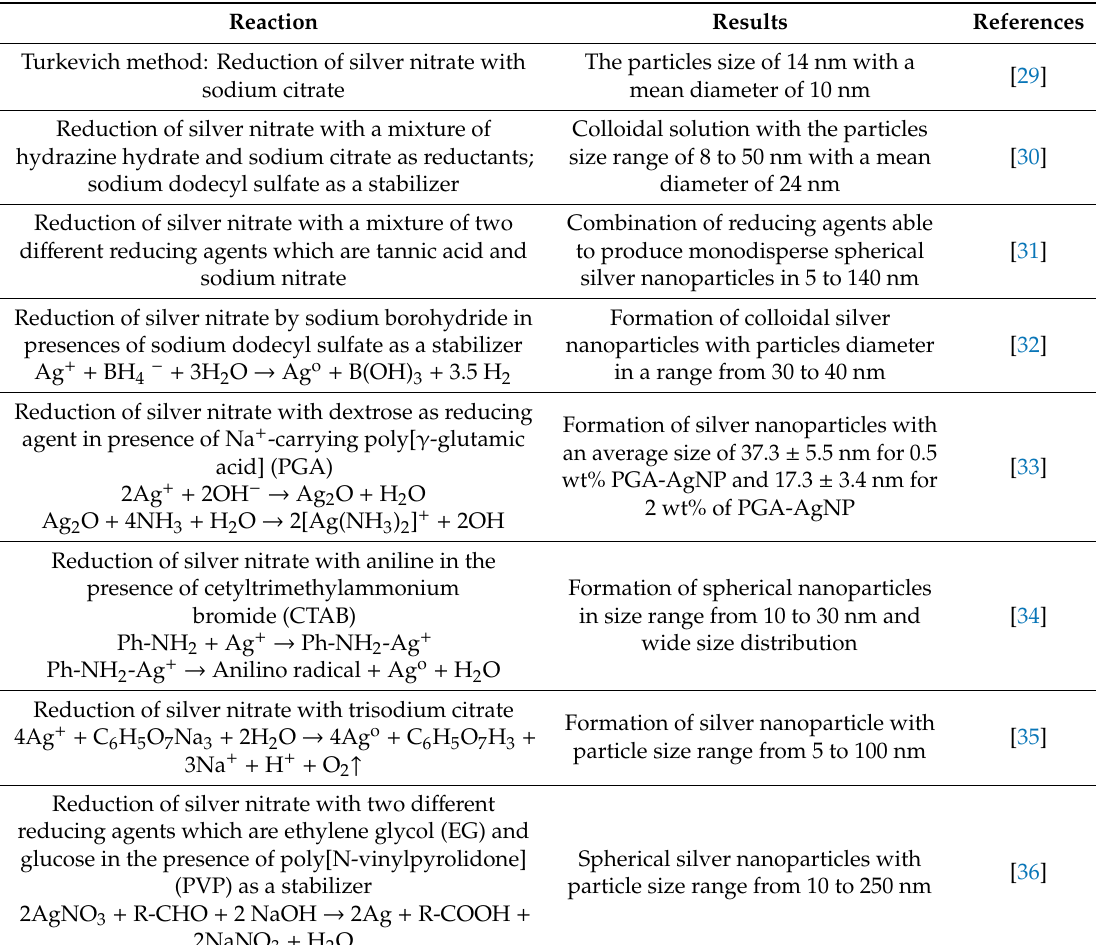
Table 2. The chemical synthesis of